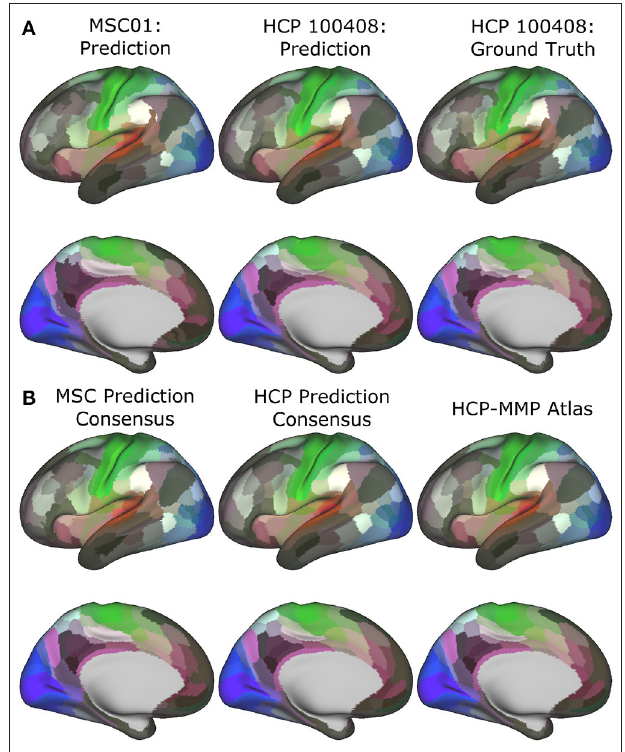
FIGURE 3 | Subject-level (A) and group-level (B) predictions generated by the optimal model in the MSC (left) and HCP (middle) datasets.